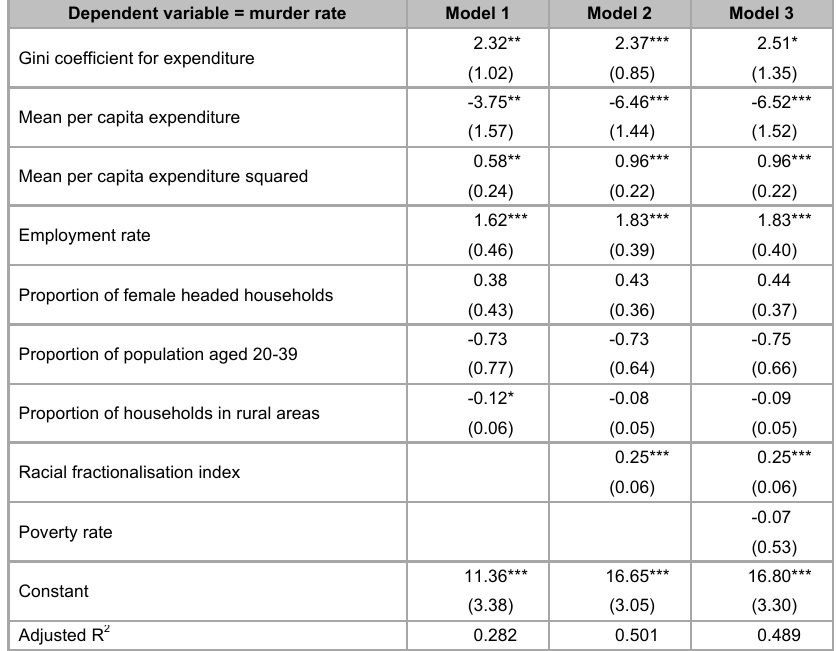
Multivariate models for the determinants of murder rates, by district: South Africa Dependent variable = murder